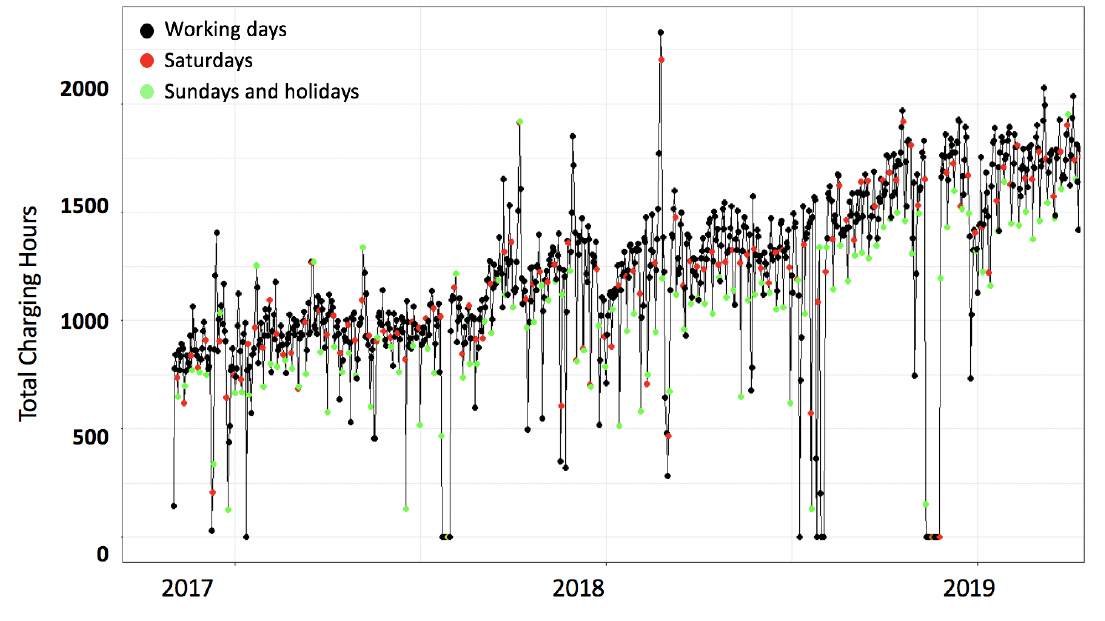
Figure 8. Total percentage of usage hours during monitored period for fast charging (CHAdemo, CCS and FastAC) grouped by location